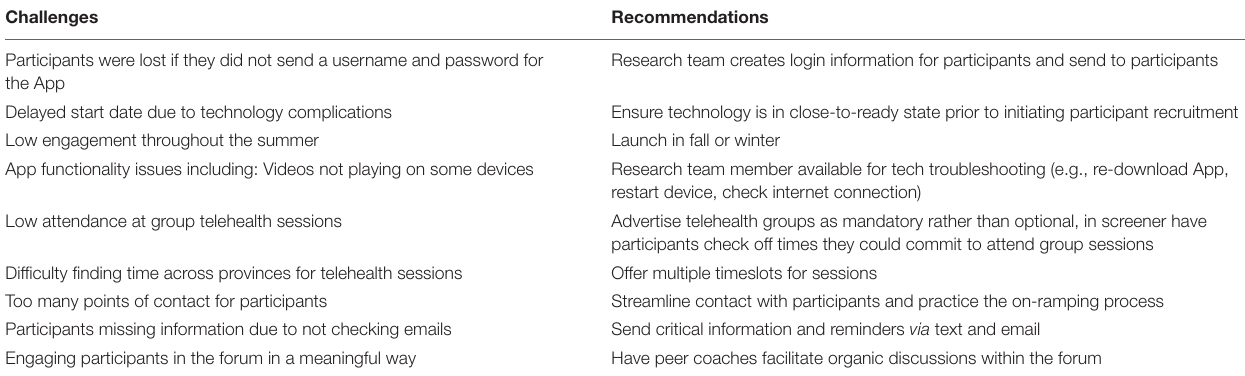
TABLE 1 | Lessons learned for facilitating the development of a digital mental health program.